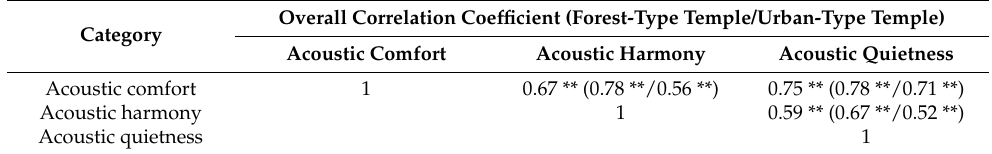
Table 4. Correlation between objective or subjective factors and temple acoustic environment eval- uation.